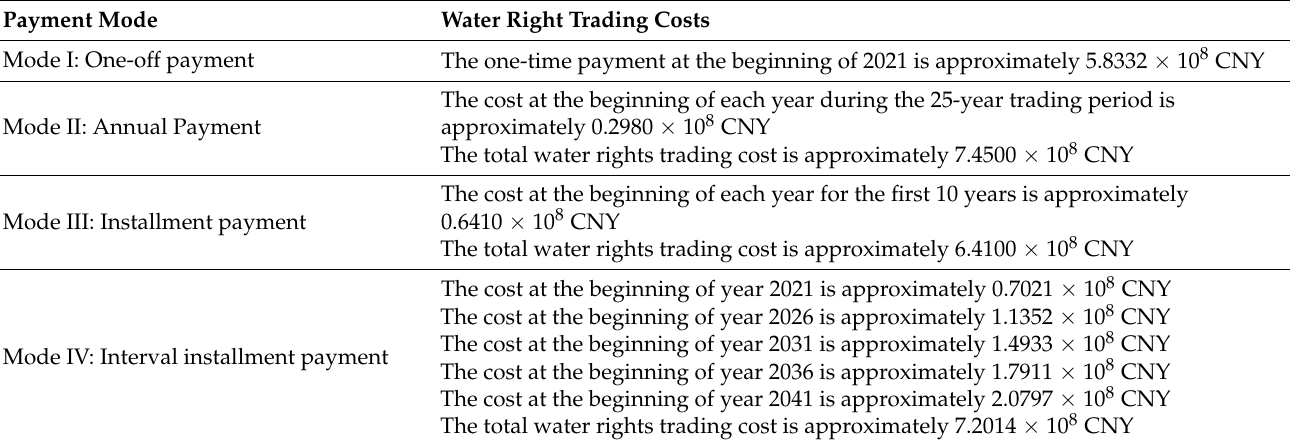
Table 8. Water rights trading costs under different payment